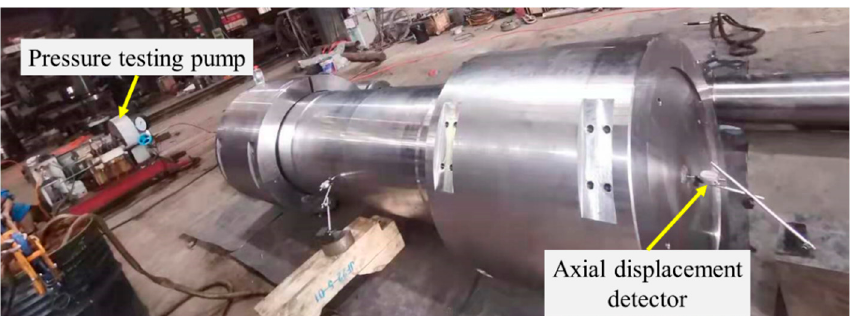
Figure 9. Pressure pump produced for a Sichuan jet.